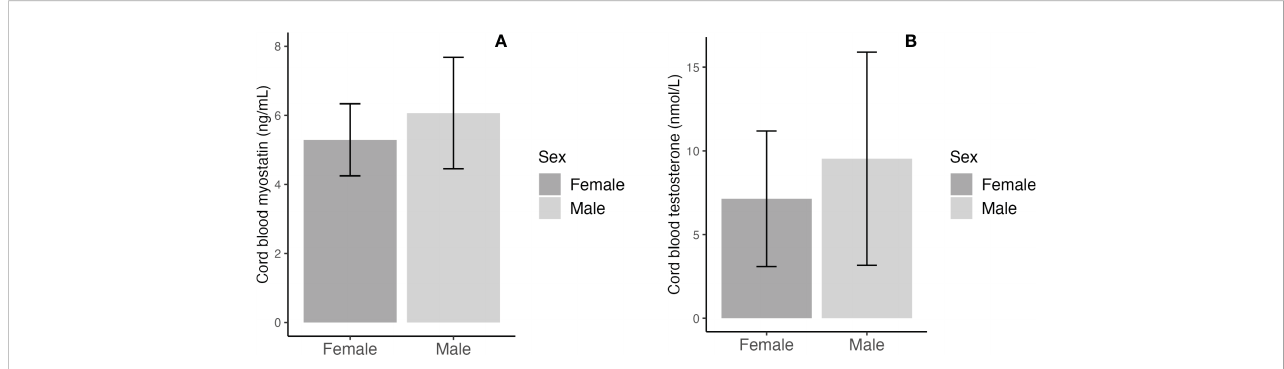
FIGURE 1 Sex differences in cord blood concentrations of myostatin (A) and testosterone (B) ; the error bars represent the mean and 95% con fi dence